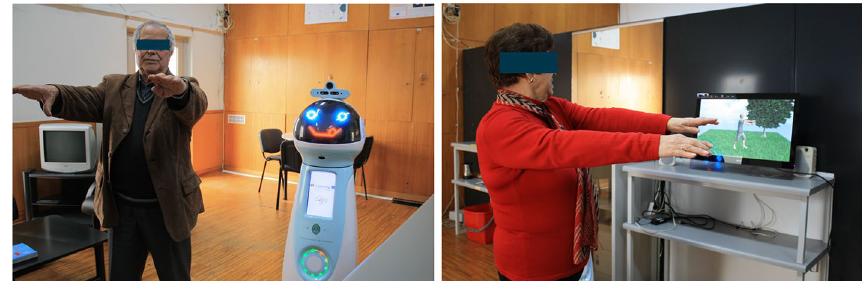
Fig. 7 Two of the voluntary participants doing the exer-